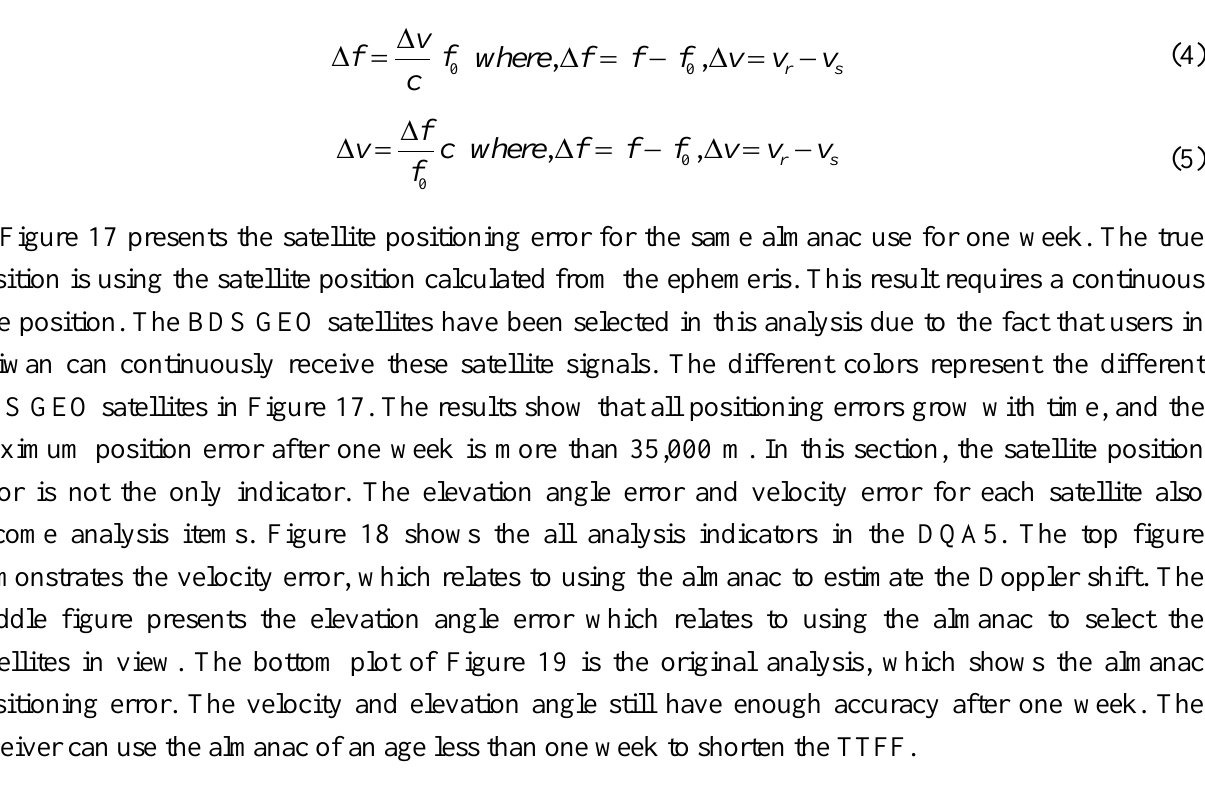
Figure 17. BDS GEO satellite position error by using the same almanac for one